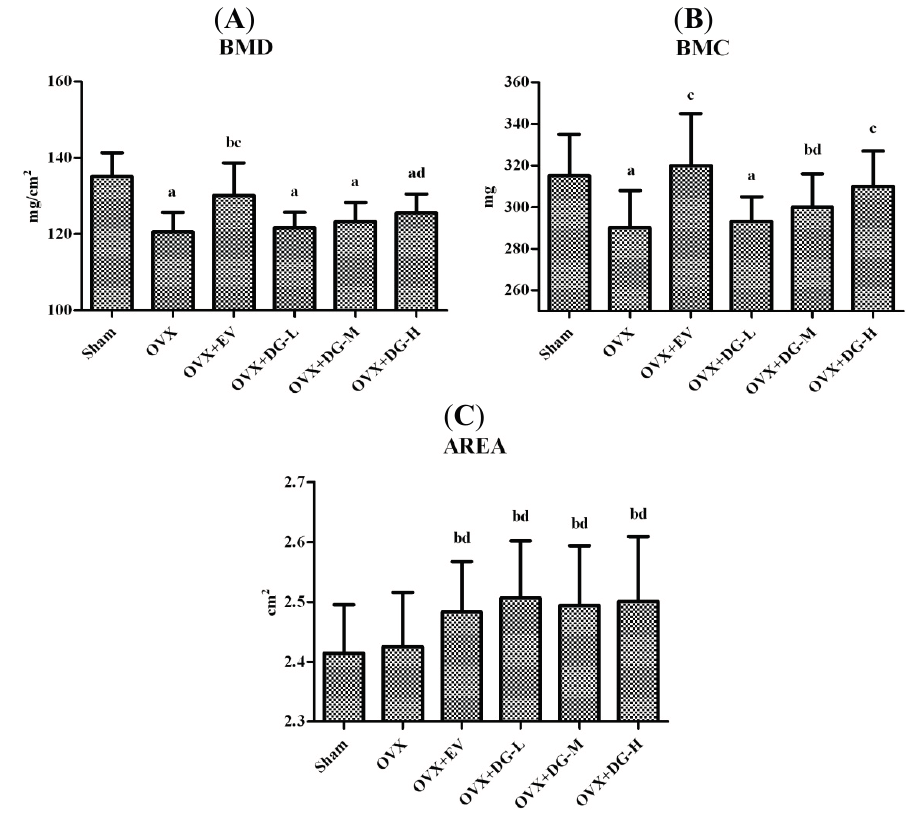
Figure 2. Effects of diosgenin on trabecular bone. Trabecular bone was visualized by using methylene blue staining. The red arrow indicates trabecular bone.